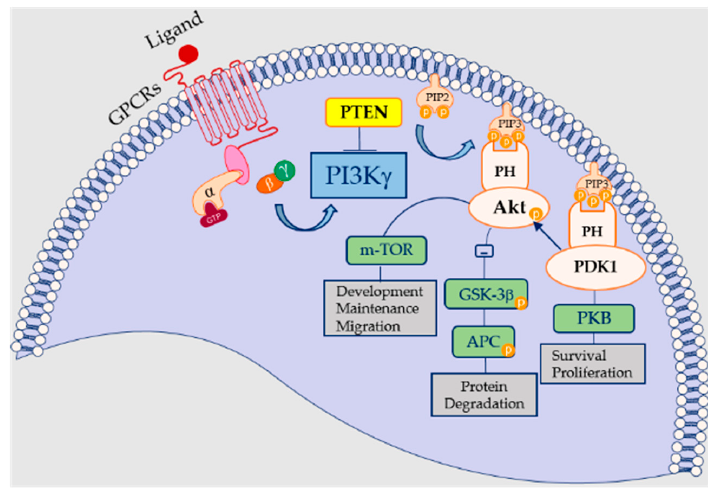
Figure 2. Representation of the main signalings in immune cells. Upon G protein-coupled receptors (GPCRs), PI3K γ catalyzes the PIP 3 formation from PIP 2 . PIP 3 binds target proteins, as Akt and PDK1, with PH domains activating intracellular pathways, as development and maintenance through m-TOR and as survival and proliferation through PKB. PIP 3 can also mediate protein degradation through GSK-3 β signaling. PTEN can inhibit PI3K γ signaling through PIP 3 dephosphorylation.